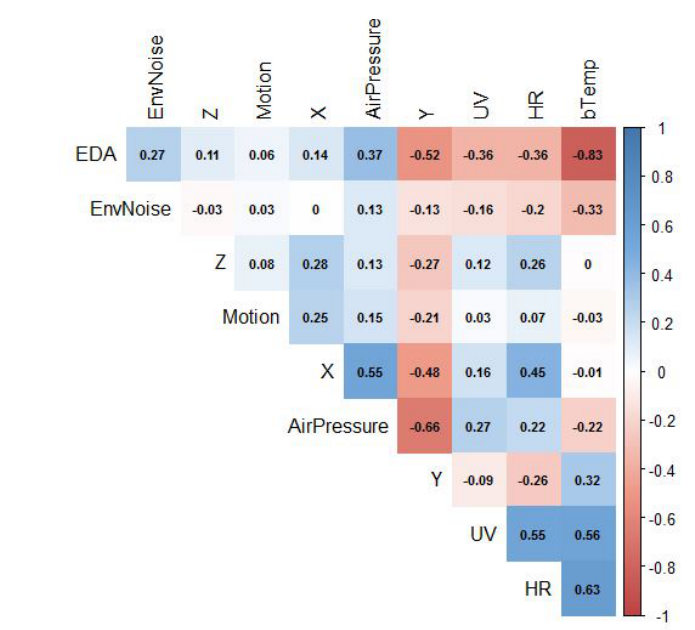
Figure 11. Correlation Matrix of all independent features according to dependent variable (Label).